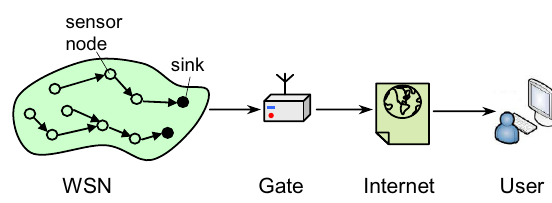
Figure 3. Typical sensor network architecture.